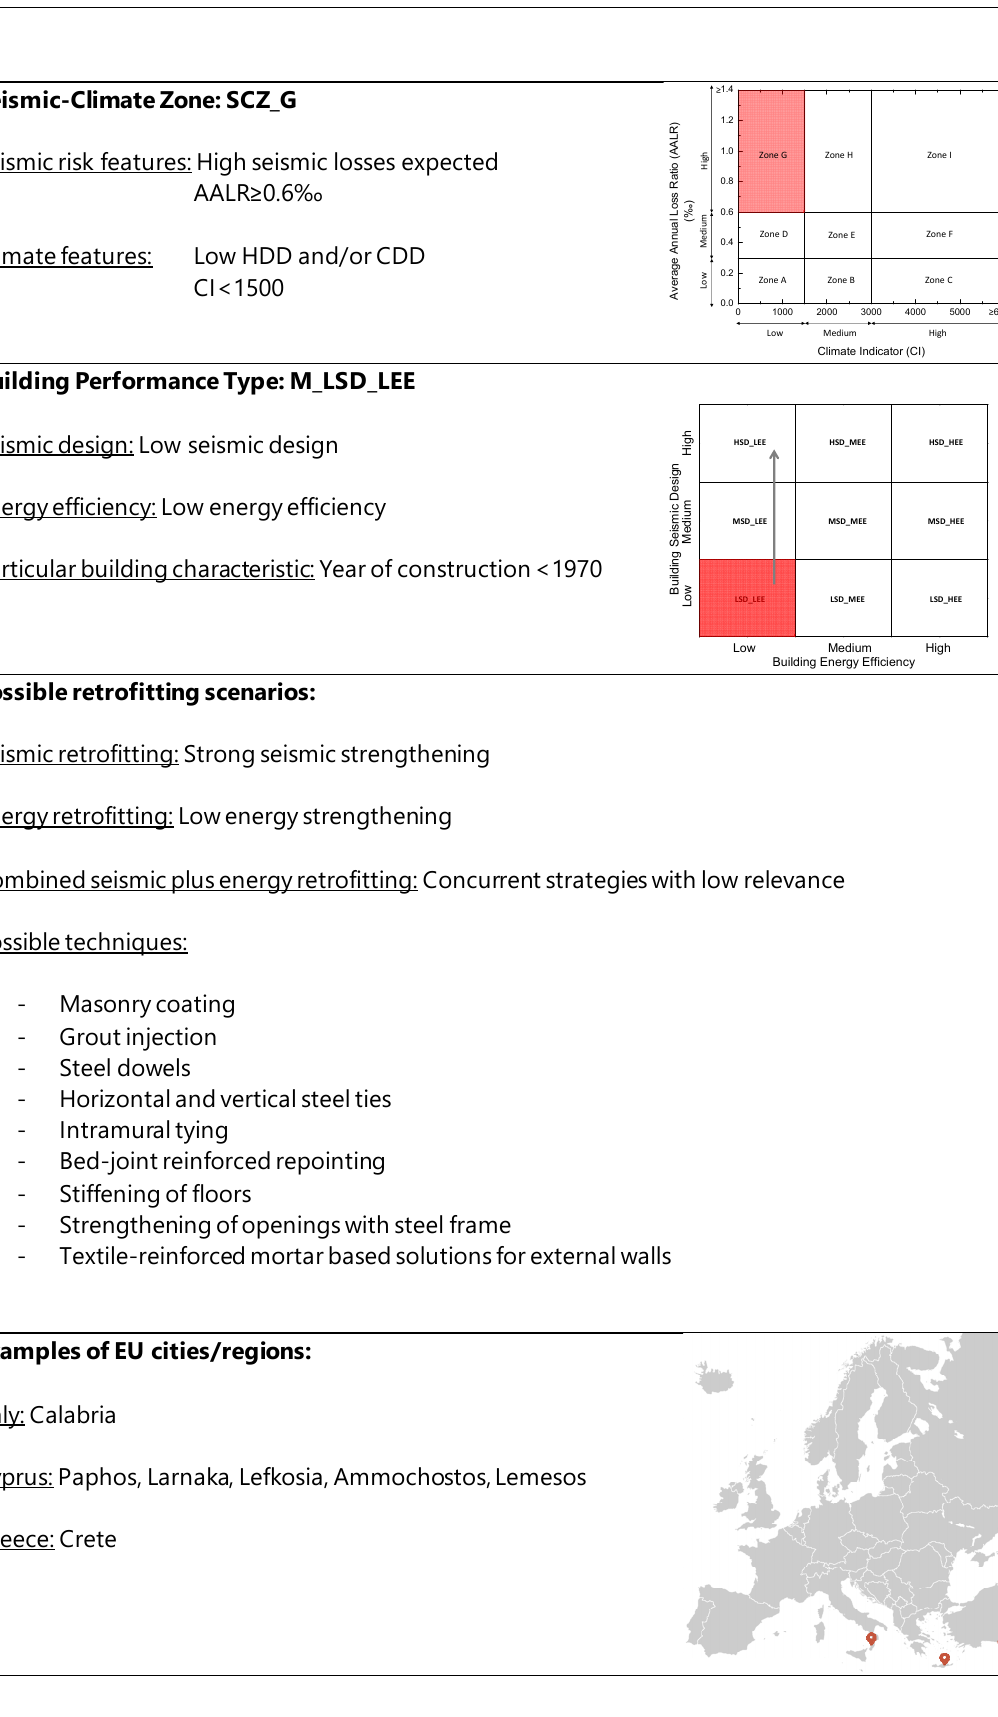
Figure 12. Retrofitting scenario 2: SCZ_G and M_LSD_LEE.